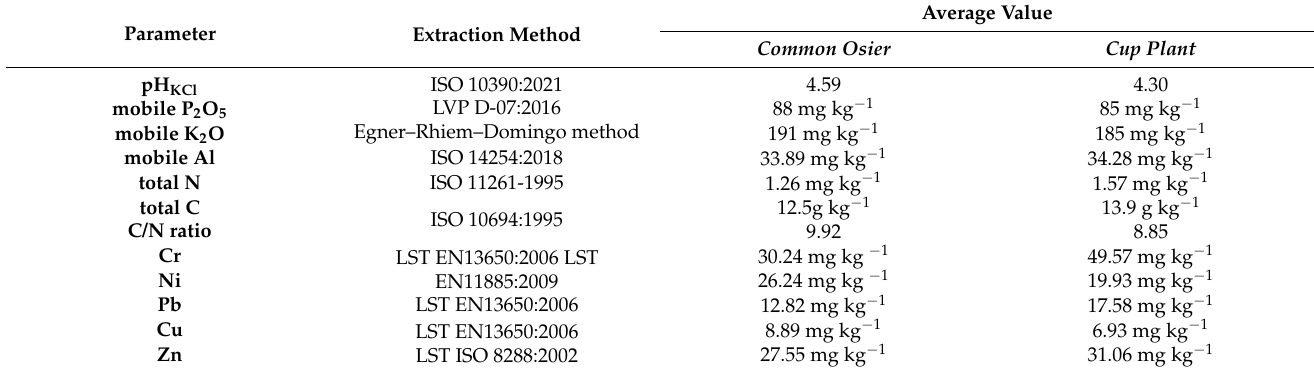
Table 1. Chemical characteristics of the experimental site prior to its establishment in April 2013.